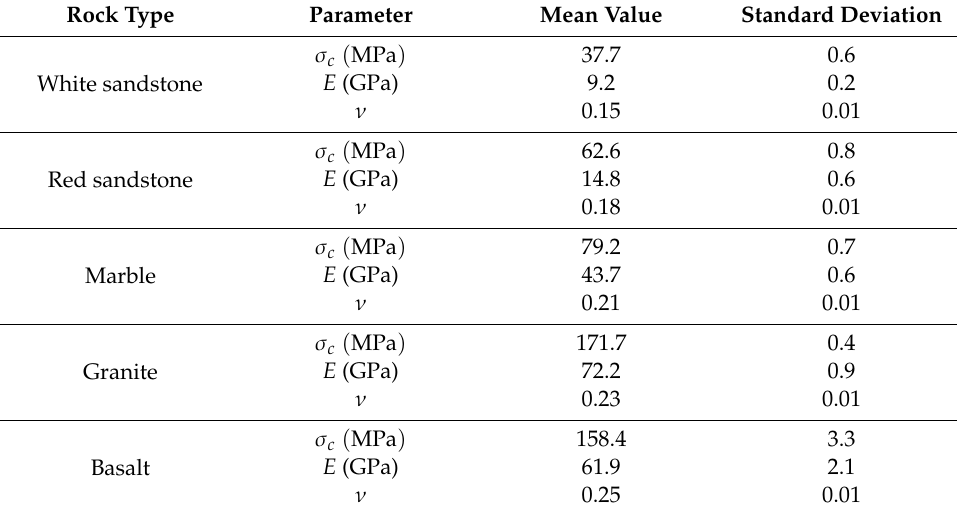
Table 1. Testing results of the uniaxial compression tests.